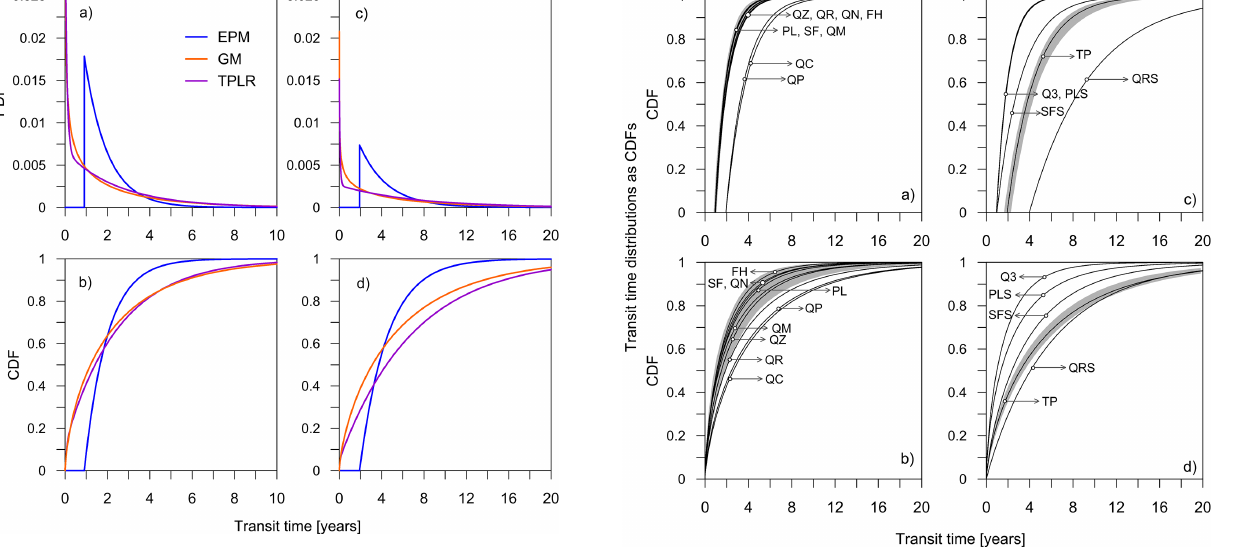
Fig. 15. Comparative results between the EPM and GM of soil water transit time distribution functions corresponding to the best NSE for every sampling site: (a) stream water of main outlet and sub- catchments using EPM and (b) using GM; (c) spring waters and creeks using LPM and (d) using GM. Gray shaded area in each plot corresponds to the range of possible shapes of the distribution function for one of the sampling sites: the main outlet (PL) in (a) and (b) and TP creek in (c) and (d)